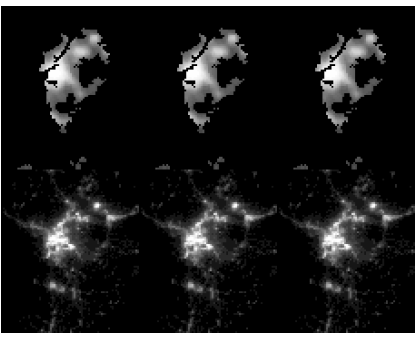
Figure 6. 2012 and 2018 comparison of distance algorithm parameter